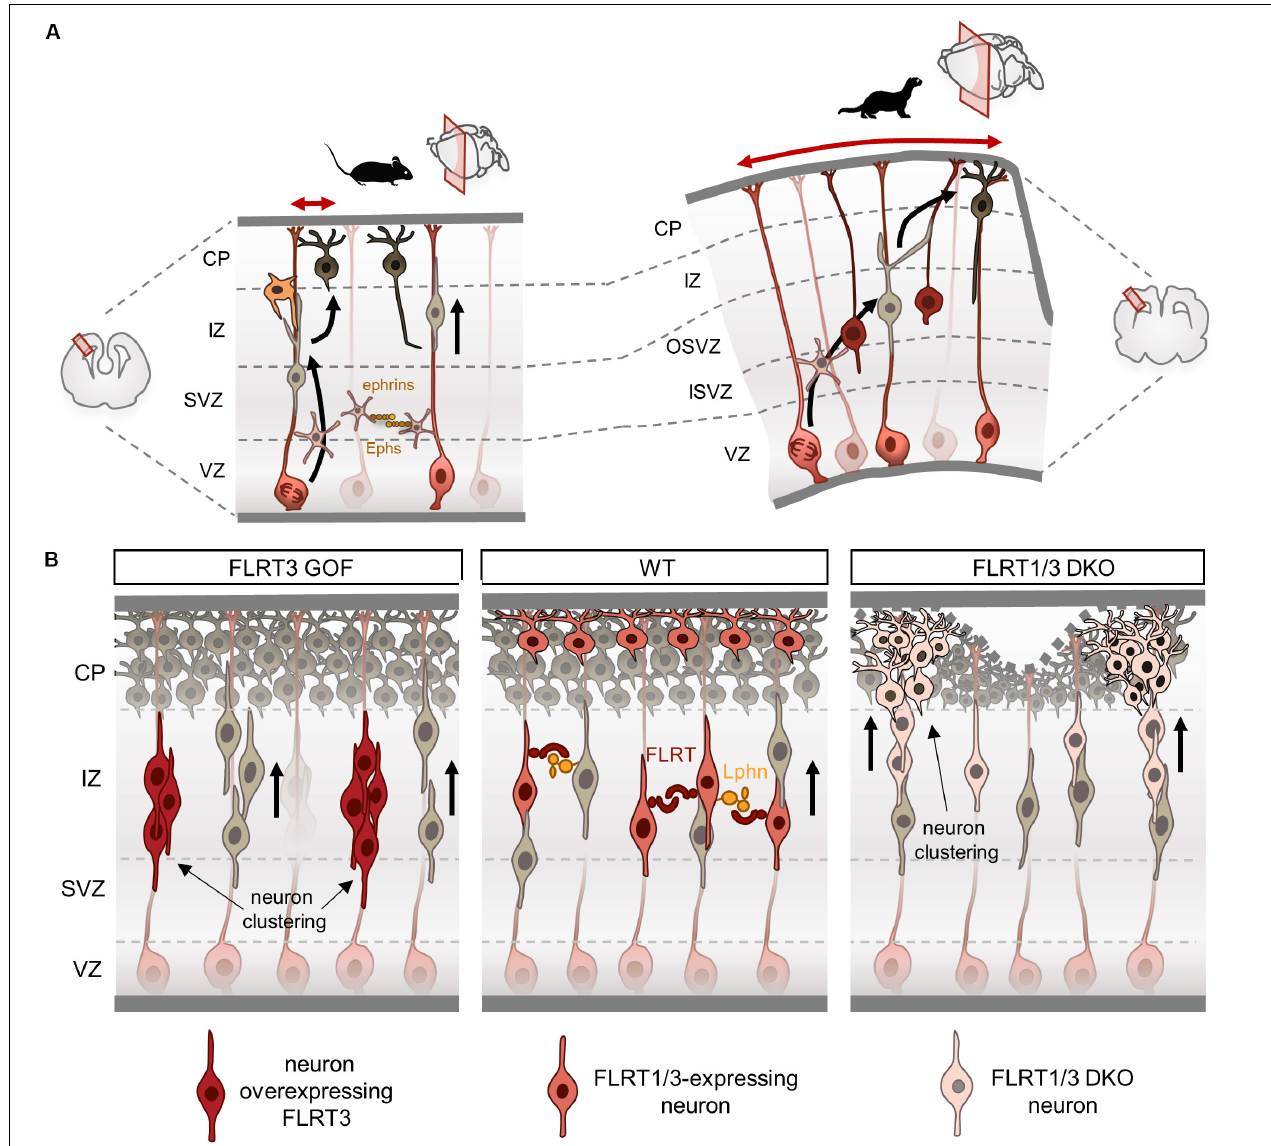
FIGURE 3 | Fibronectin leucine-rich repeat transmembrane proteins (FLRTs) modulate tangential dispersion by adhesion. (A) Scheme illustrating tangential dispersion in the lissencephalic mouse and the gyrencephalic ferret during cortical development. In the mouse, pyramidal neurons mostly migrate radially along a single parent RG. Conversely, neurons in the ferret do not follow strict radial pathways and instead disperse in the lateral axis. (B) Current model of tangential dispersion modulated by FLRTs. In the wild-type (WT), FLRT1/3+ neurons show homogeneous distribution while migrating to the CP at E15.5. FLRT3 overexpression induces cell clustering in the IZ and delays migration. Loss of FLRT1/3 results in faster migration and clustering in the lower and upper CP. Loss of adhesion may alter tissue elasticity inducing a wavy upper surface of the CP, which can lead to sulcus